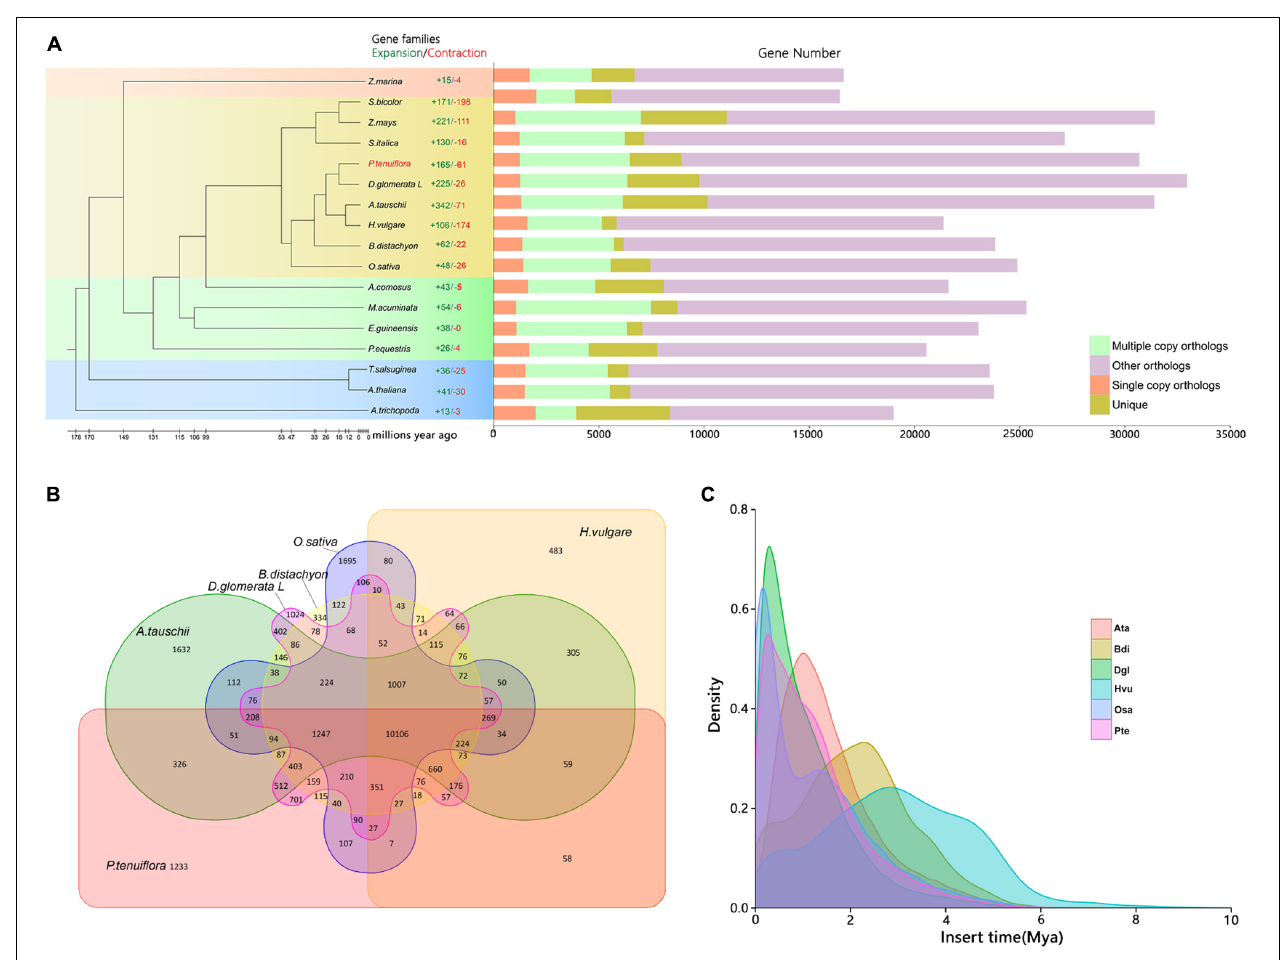
FIGURE 1 | Gene family, phylogenetics, and time of LTR-retrotransposon insertion in Puccinellia tenuiflora. (A) Phylogenetic relationship of P. tenuiflora and 16 plant species with sequenced genomes. The phylogenetic tree was constructed using maximum-likelihood analysis and alignment of 228 single copy proteins. (B) Venn diagram of gene family comparison among P. tenuiflora and several sequenced Gramineae plants. (C) Time of LTR-retrotransposon insertion in P. tenuiflora (Pte) , Oryza sativa (Osa) , Dactylis glomerata (Dgl) , Hordeum vulgare (Hvu) , Aegilops tauschii (Ata) and Brachypodium distachyon (Bdi).